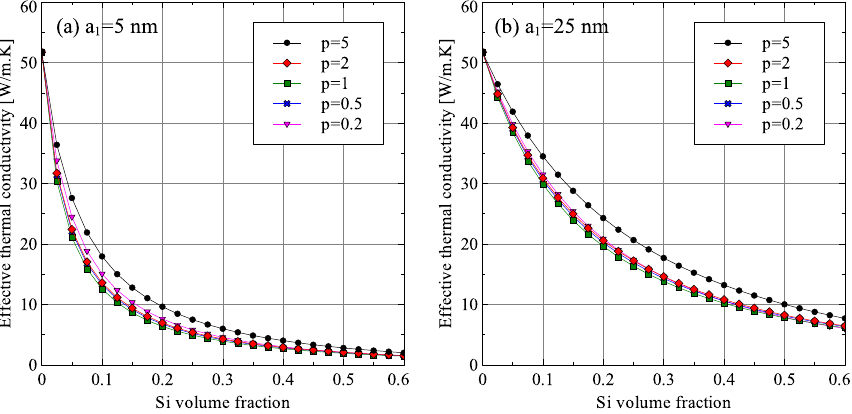
Figure 15. Dependence of Ge–Si effective thermal conductivity on inclusion aspect ratio p for inclusion size a 1 equal to: ( a ) 5 nm; and ( b ) 25 nm ( R TB = 6.80 × 10 − 9 m 2 · K/W).